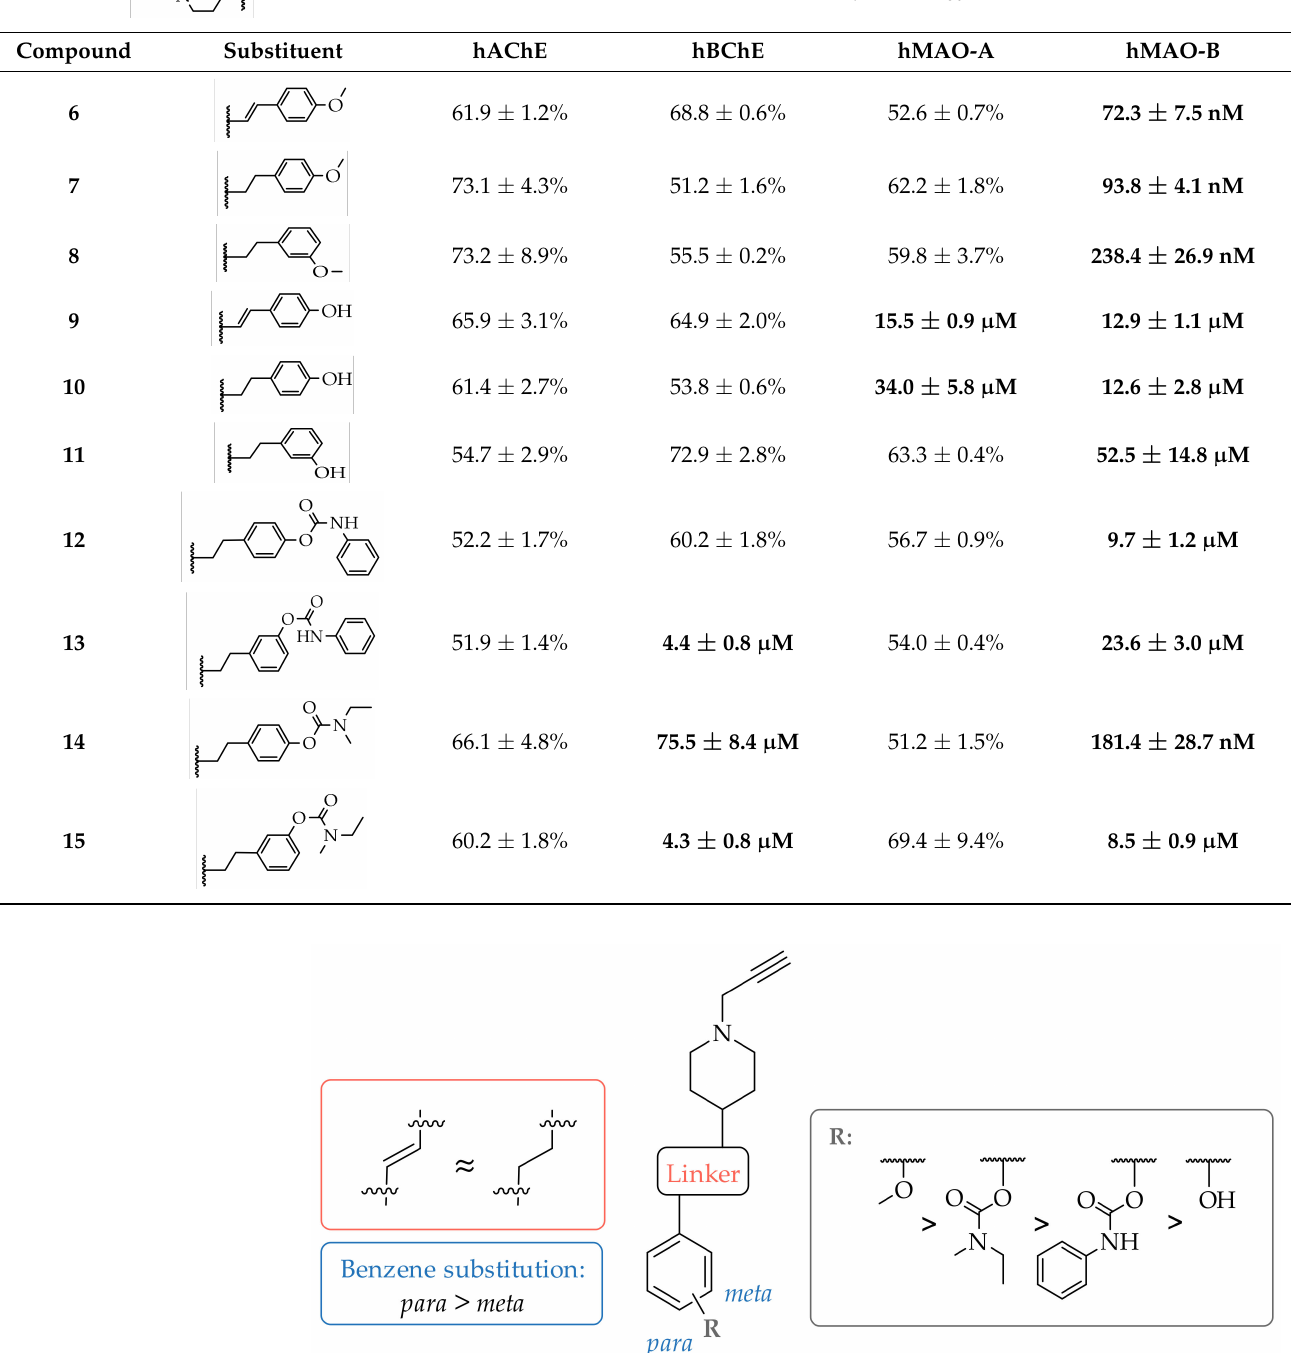
Figure 2. Structure activity relationships for hMAO-B